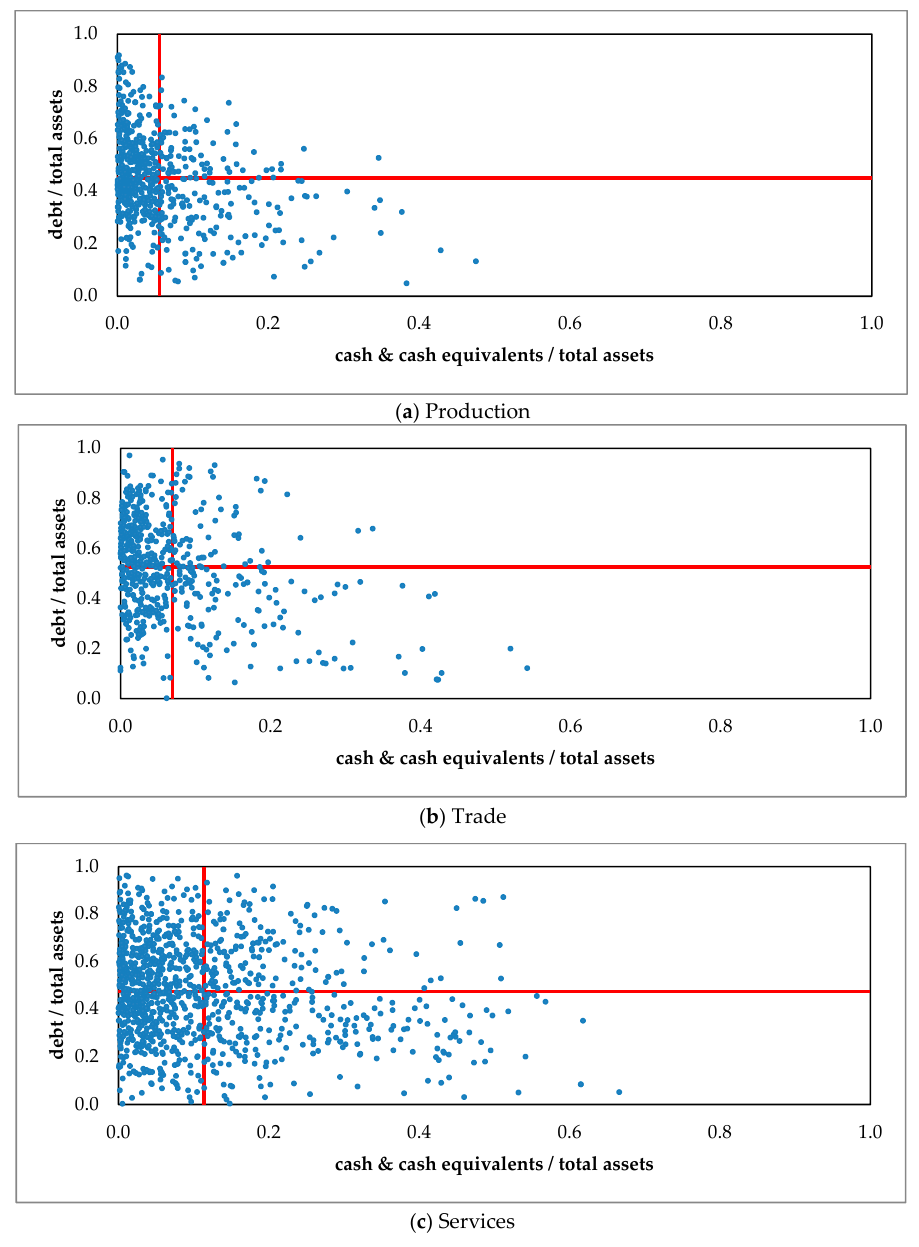
Figure 2. Dispersion of debt capacity constraint (debt to total assets) and liquidity constraint (cash and cash equivalents to total assets) in the examined sample (N = 2292). Red lines reflect the mean values.